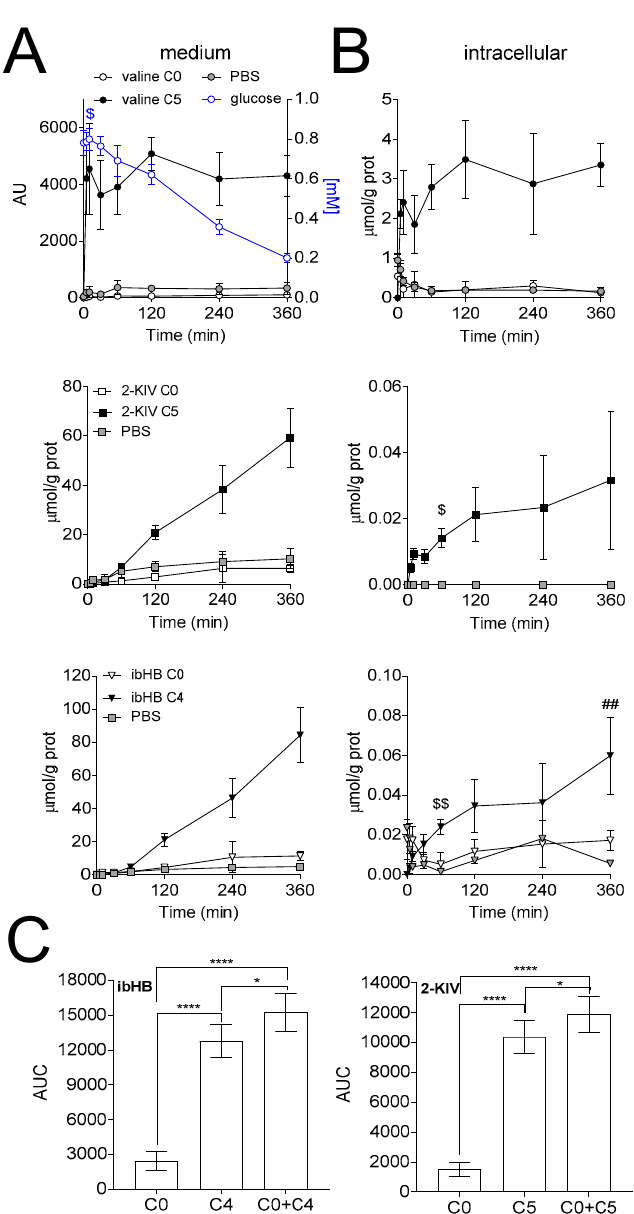
Figure 3. Isotopomer analysis in astrocytes. Extracellular ( A ) and intracellular ( B ) time courses of valine, 2-KIV and ibHB concentrations in the iPSC-derived astrocyte experiment. ( C ) AUC of the secreted ibHB and 2-KIV. Glucose concentration was measured in the medium and is depicted in blue (A). (n = 3). ## p < 0.01, as compared to 60 min; $ p < 0.05 and $$ p < 0.01, as compared to 30 min paired t-test. (C) * p < 0.05 and **** p < 0.0001, one-way ANOVA with Tukey’s post-test for multiple comparisons. AU: arbitrary